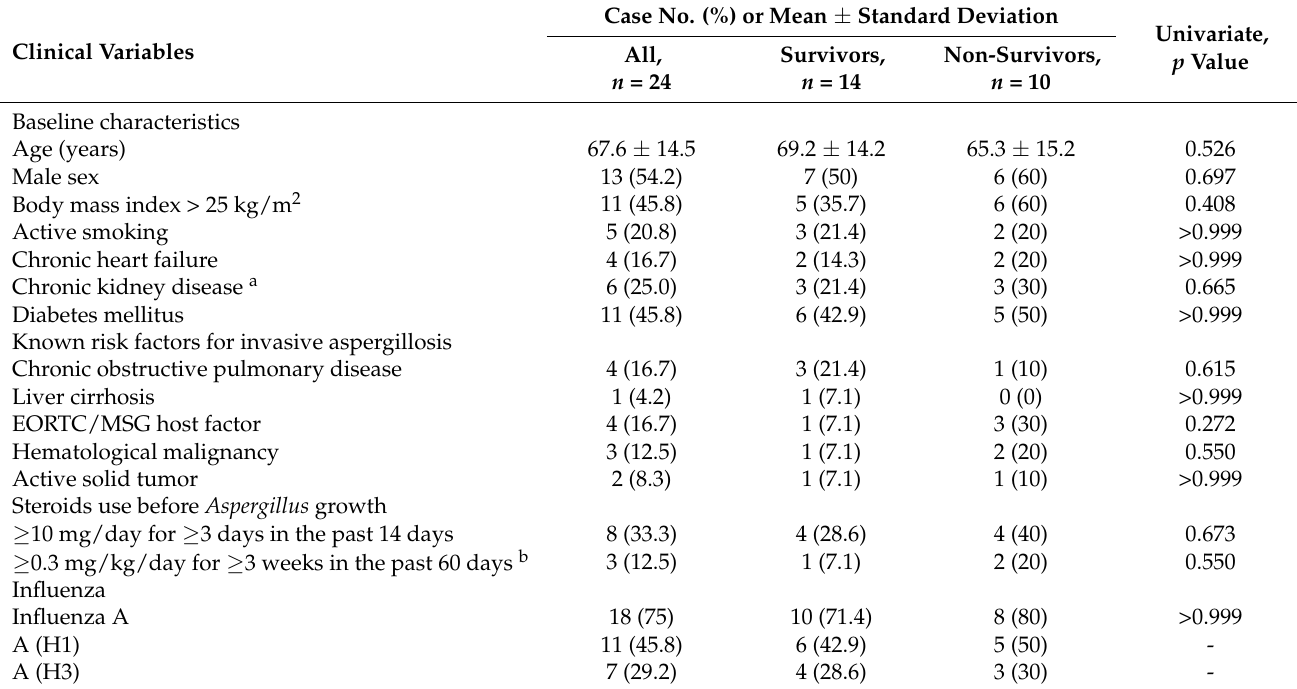
Table 1. Characteristics of 24 patients with influenza-associated pulmonary aspergillosis